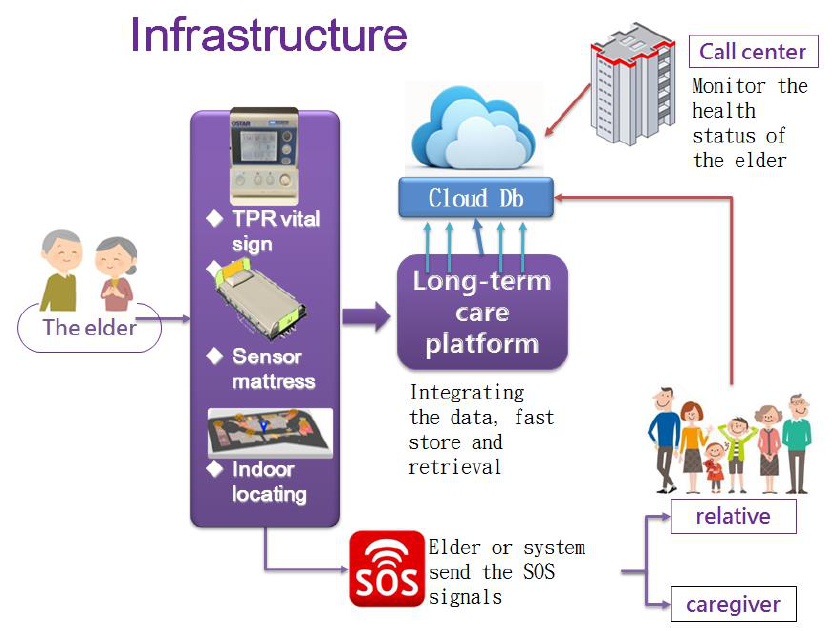
Figure 1. The infrastructure for the incorporation of ICT into long-term care (note: TPR means temperature, pulse, and